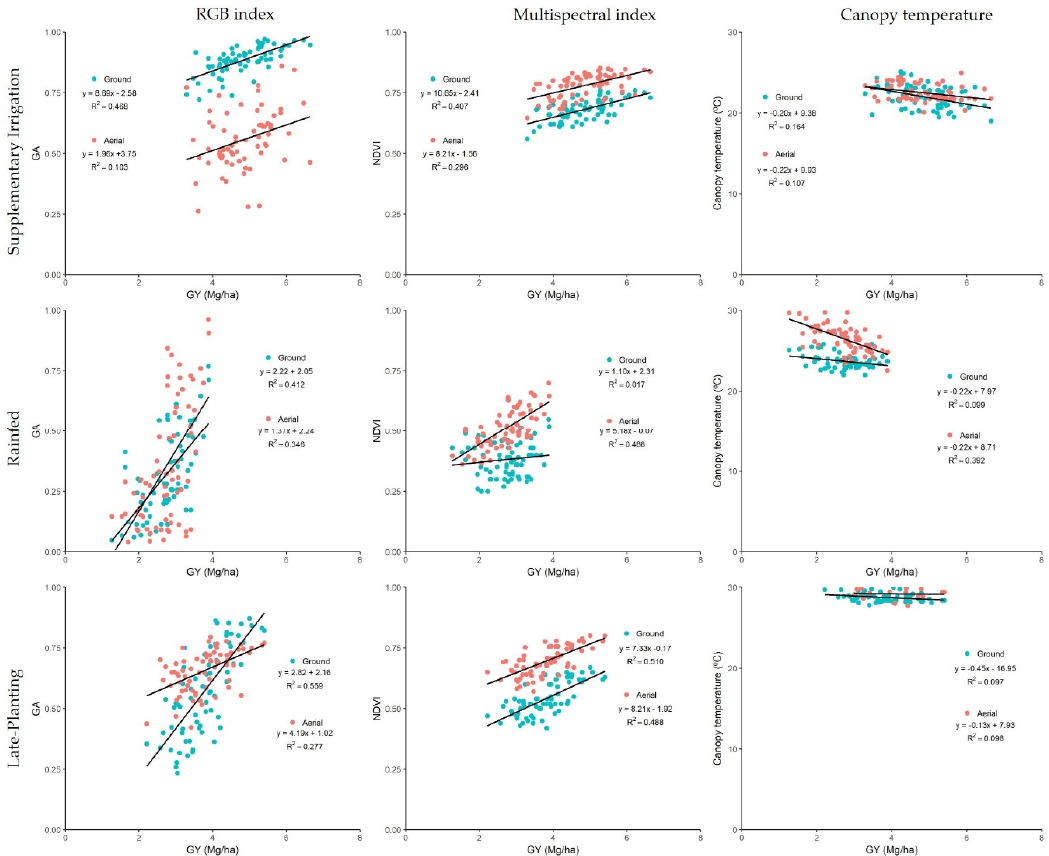
Figure 4. Relationships between grain yield with the RGB index green area (GA) (left), the multispectral index NDVI (middle) and the canopy temperature (right), measured from the ground level (red points) and from the aerial level (blue points) during grain filling for the supplementary irrigation (top), the rainfed (middle), and the late-planting (bottom) growing conditions. Correlations were studied across the 72 plots from each growing condition.